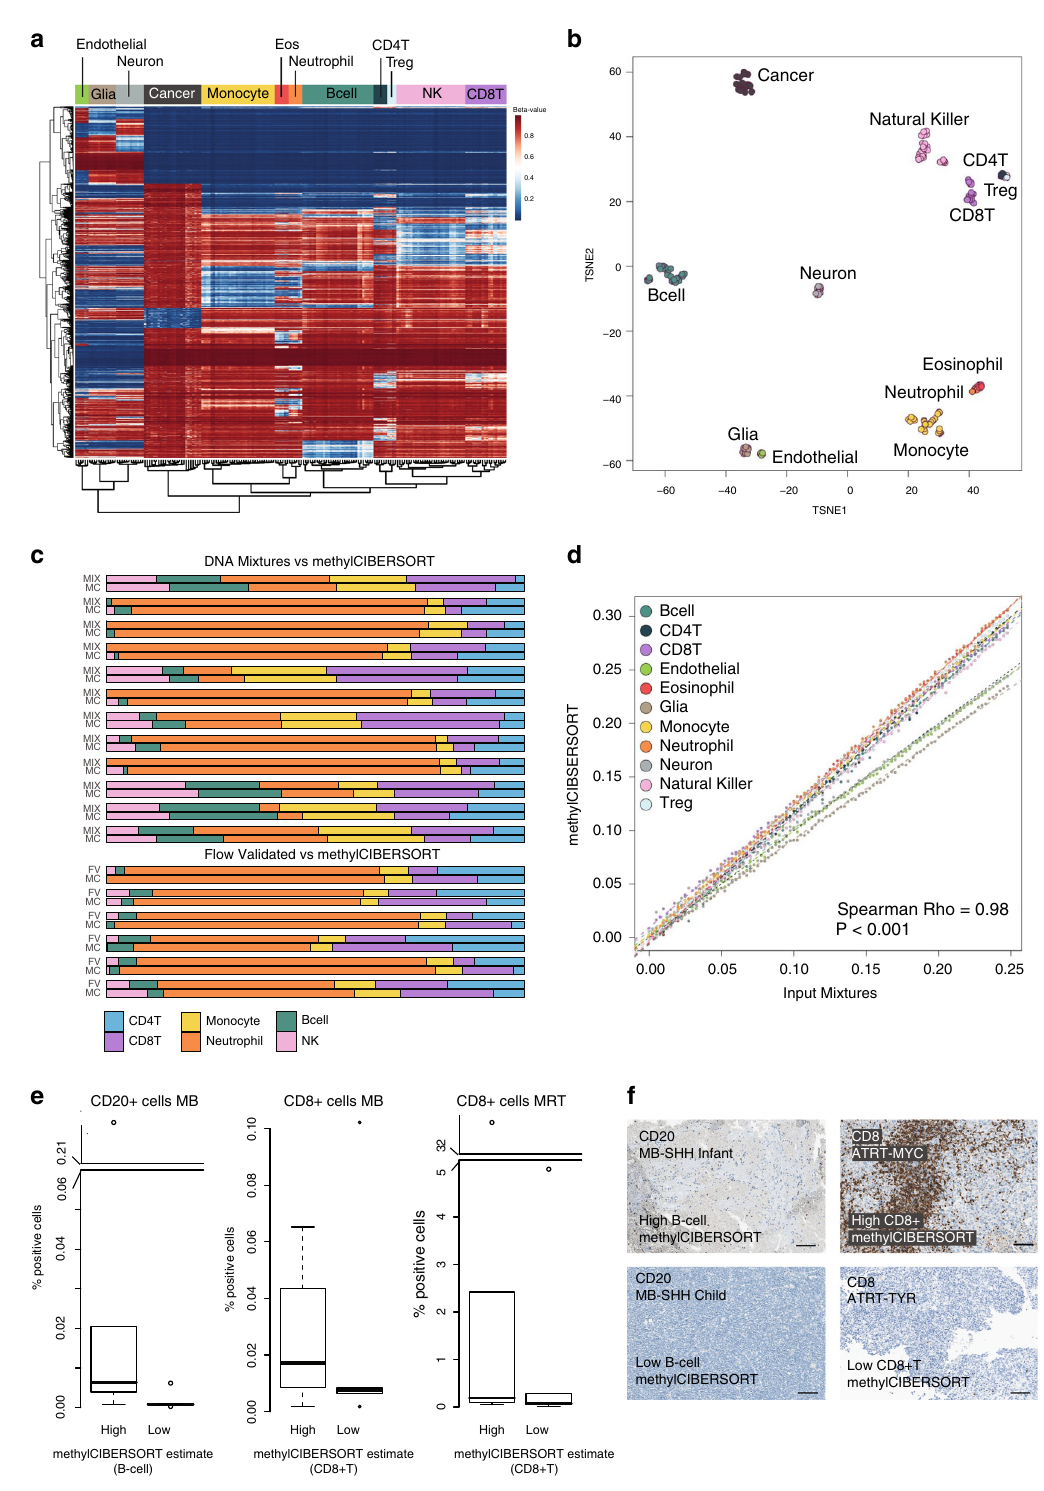
tumor methylation pro fi les (plus an additional 141 control/ hematopoietic samples, see Supplementary Table 4) published by Capper et al. 31 . This reference set is the training resource of the Molecular Neuro-Pathology 2.0 classi fi er and represents 80 methylation tumor types/subtypes closely related to WHO his- topathological entities and divided into 13 broad histological categories. A relative proportion of the 12 cell types were esti- mated and indicators of deconvolution performance examined. As further validation, the relative proportion of cancer cells